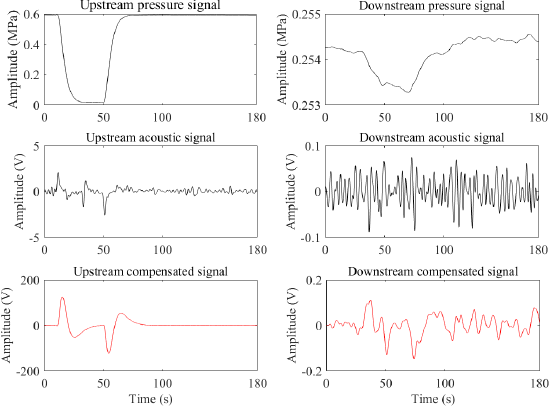
Figure 11. The case of the pressure fluctuation.